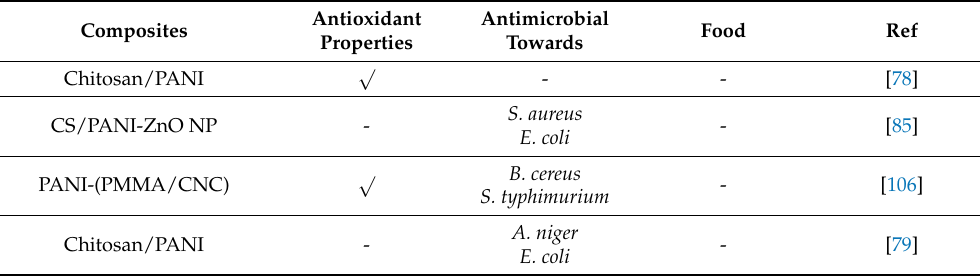
Table 2. Some examples of antioxidant and antimicrobial applications of PANI and PANI composites.